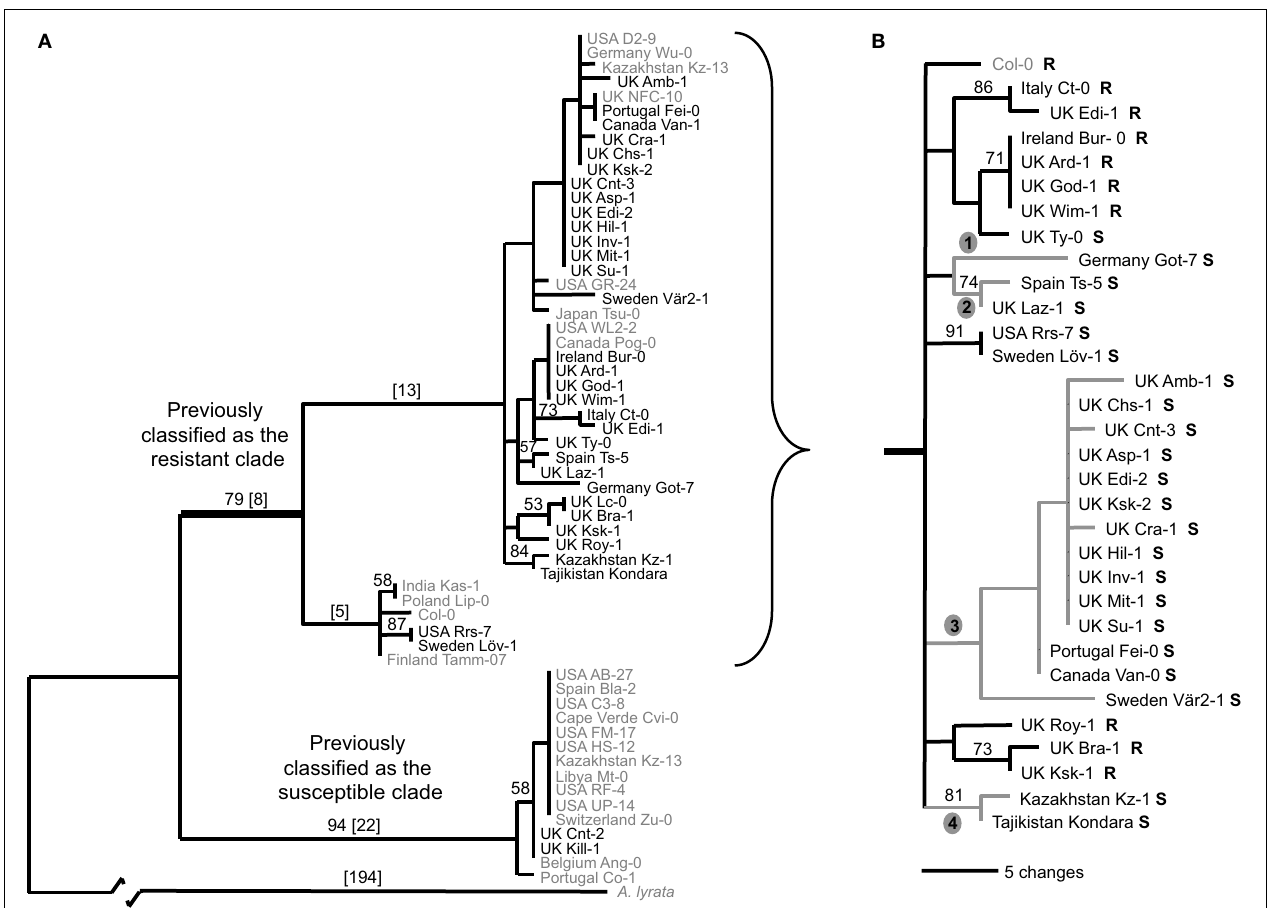
gray. No sequence data was available for the accessions from Stahl et al. from 1743bp onward.These positions were treated as missing data in the analysis. Bootstrap values are indicated above branches; branch lengths are in square brackets. Resistance (R) or susceptibility (S) based on HR to DC3000 carrying AvrRpm1 indicated next to accession name.The four new branches on which loss-of-function substitutions occurred are indicated.The specific substitutions are found in Table 1